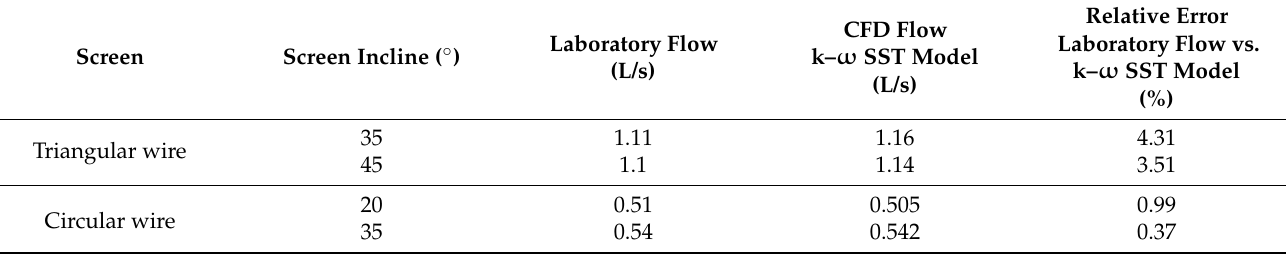
Table 7. Comparison of the Flow Obtained with Experimental Data vs. Numerical Simulation.